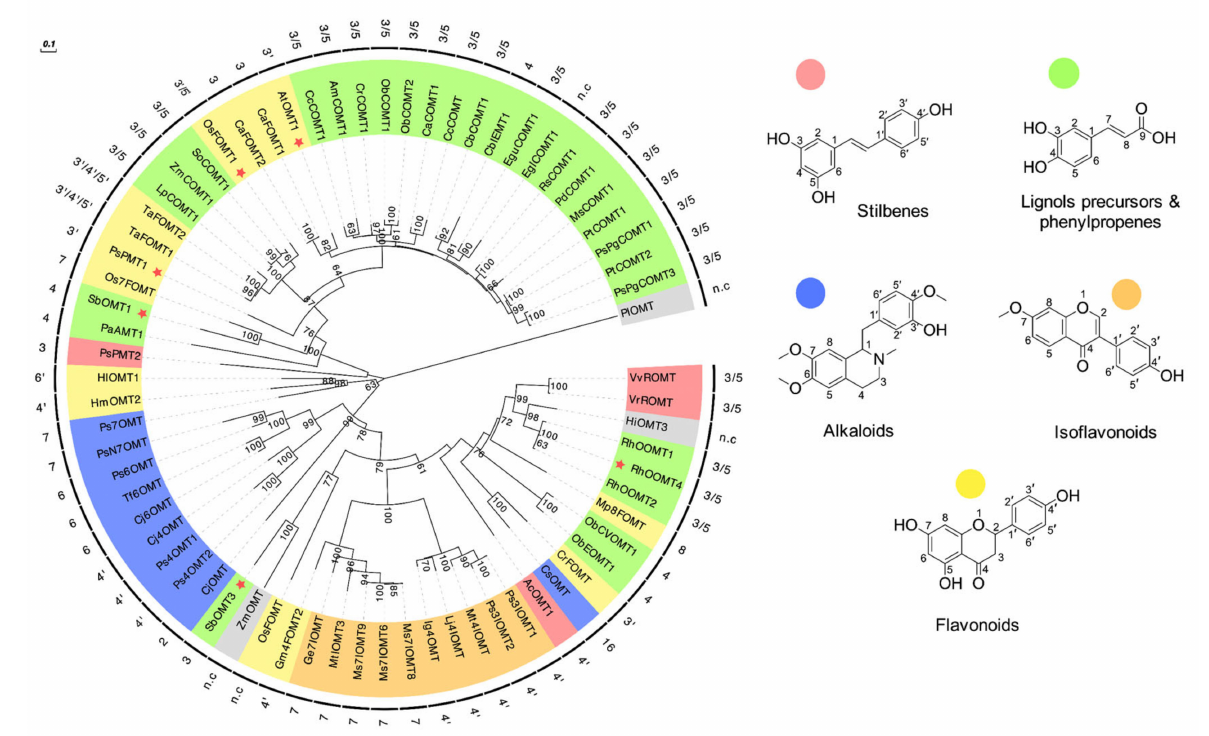
Figure 1. Phylogenetic tree of VvROMT and related plant OMT-I enzymes. The inner ring of labels corresponds to the abbreviated name of each enzyme and the outer ring shows its regioselectivity. The color is related to its preferred phenyl- propanoid substrate (chemical structure example is shown at the right). The tree was inferred by the Maximum Likelihood method with MEGA X software and reliability was assessed by bootstrapping (1000 iterations); only values greater than 60 are shown. The enzymes HiOMT3 and ZmOMT in grey are still uncharacterized. PIOMT, demethylpuromycin-OMT was used as an outgroup. Pink stars represent promiscuous enzymes also active on stilbenes. See Supplementary Table S2 for the complete list of OMT-I sequences used. n.c: not